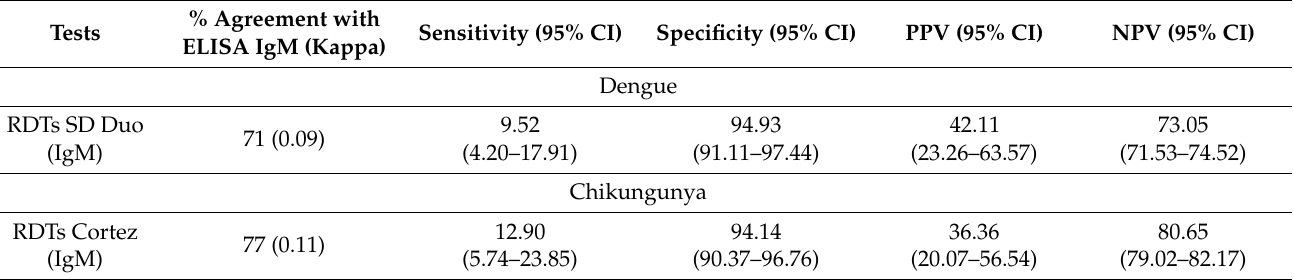
Table 7. Agreement, sensitivity, specificity, PPV, and NPV of RDTs versus ELISA used as